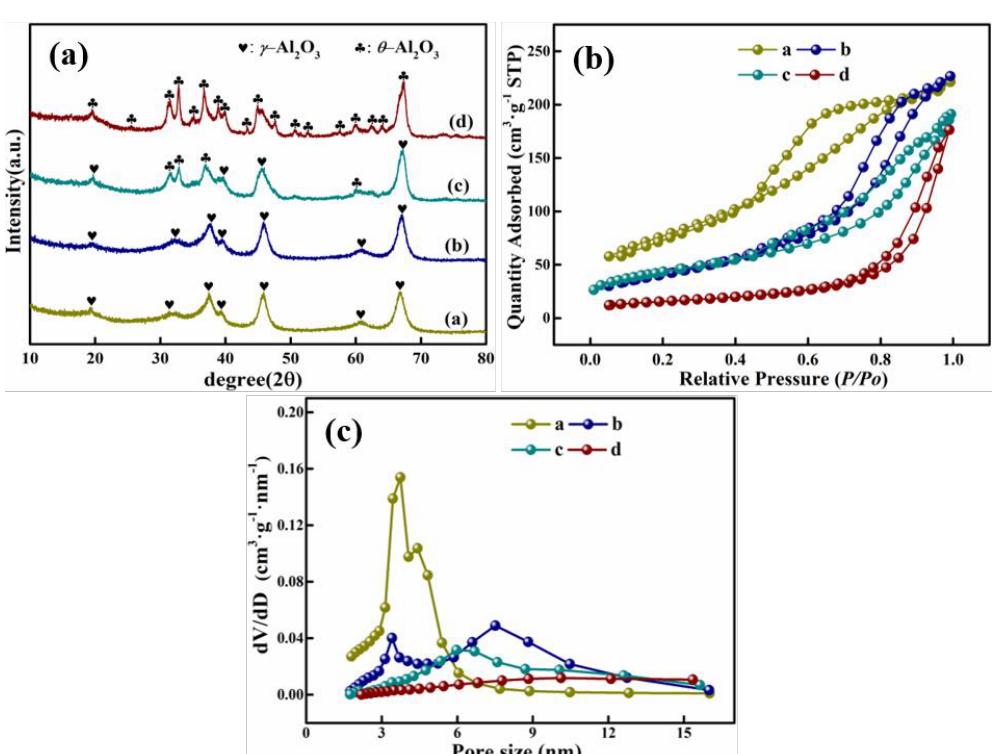
Figure 6. XRD patterns; ( a ) nitrogen adsorption-desorption isotherms; ( b ) pore-size distribution curves ( c ) of HPMA products obtained at different roasting temperatures: ( a ) 500 °C; ( b ) 700 °C; ( c ) 900 °C.